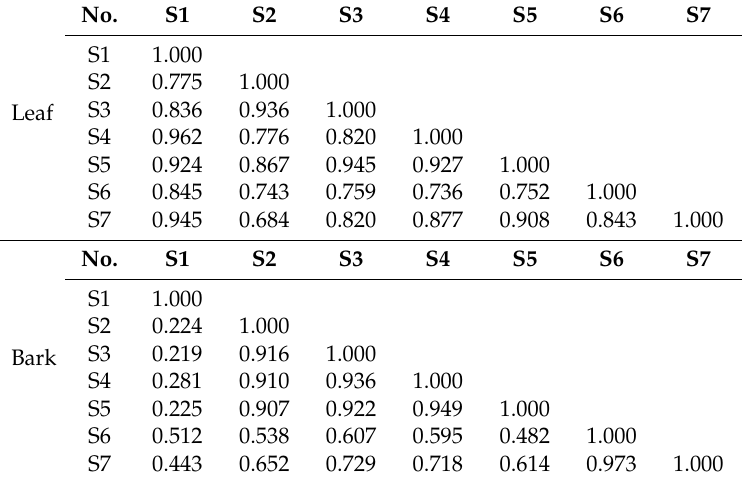
Table 7. Similarities of chromatograms of leaf and bark of different E. ulmoides varieties based on